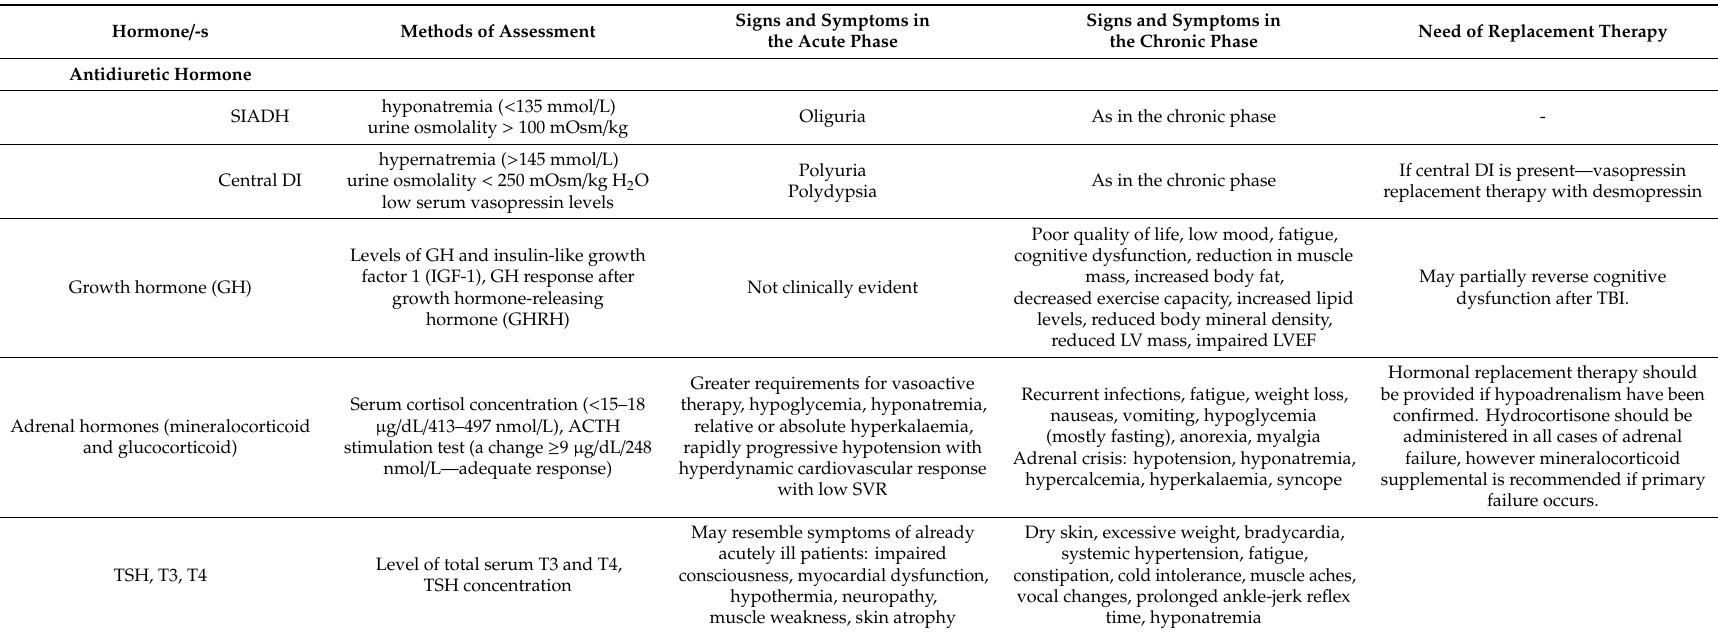
Table 1. Endocrine manifestations in acute brain injury